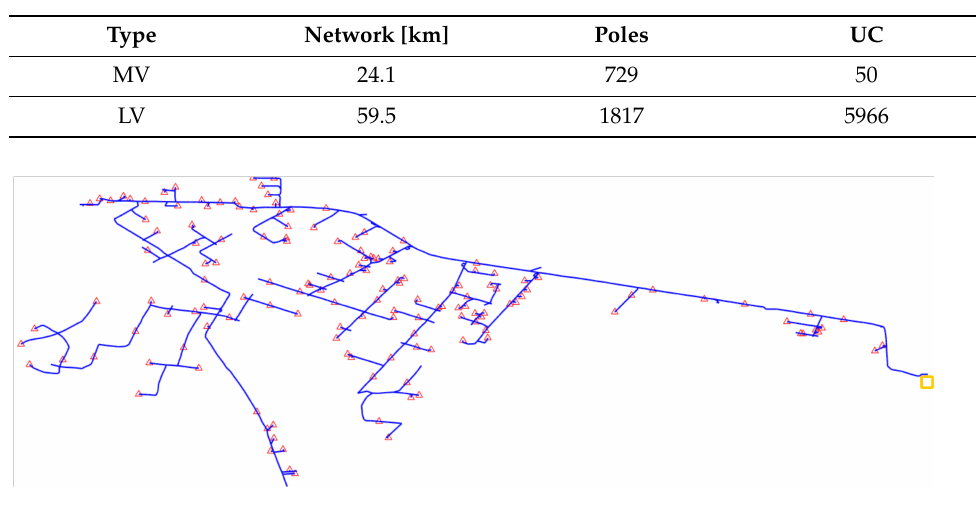
Figure 3. Feeder- α medium voltage circuit map.